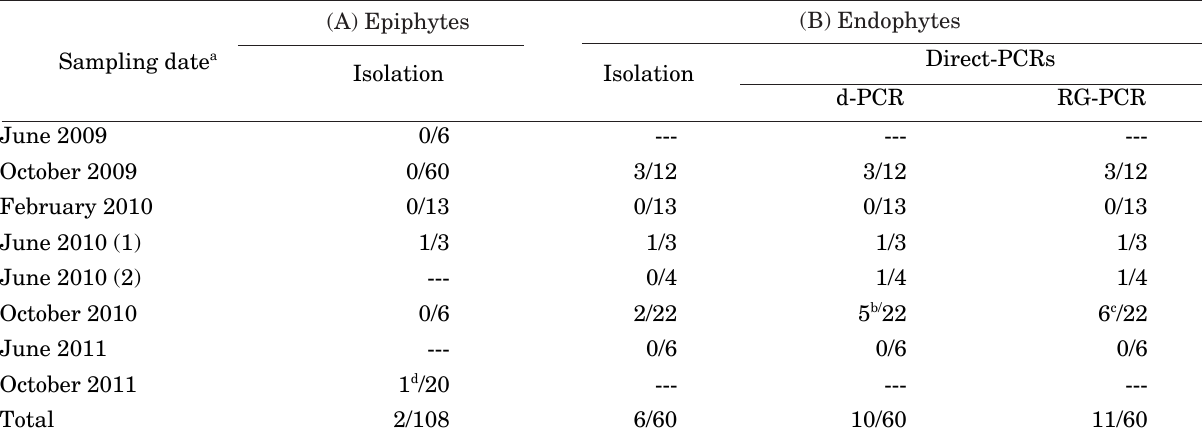
Table 2. Pseudomonas syringae pv. actinidiae (Psa) detection in symptomless fruits from 2009 to 2011 as epiphytes from washing (A) and as endophytes from cones of columellae cuts from the apices of fruit (B). The number of positive samples divided by the total number of tested samples is reported for each sampling. For endophytic Psa detection, the results of comparisons between isolation and direct-PCR are also reported. RG-PCR refers to Rees-George et al. (2010), d-PCR to Gallelli et al.